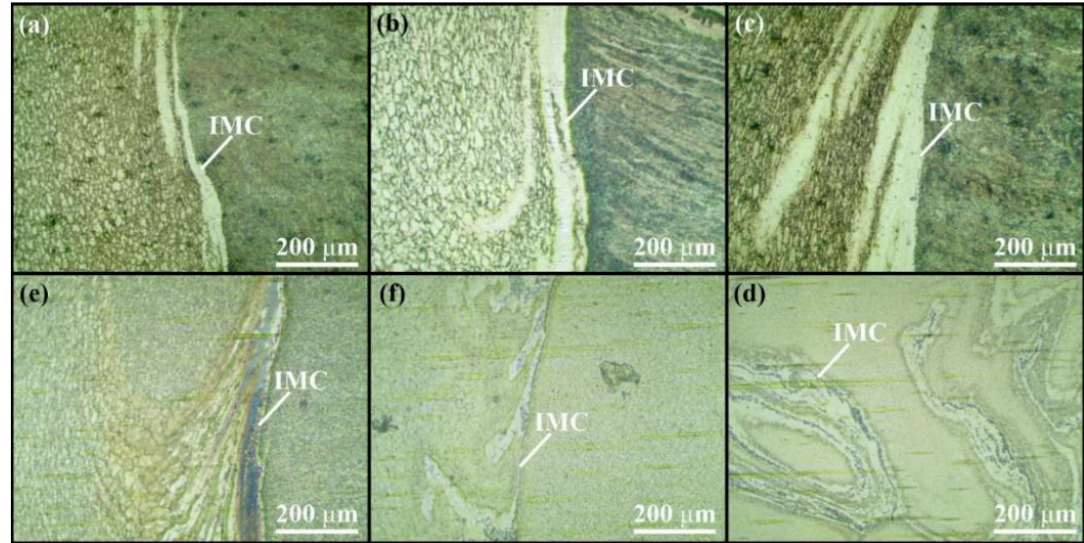
Table 5. Effect of FSW parameters on the strength of the Ti-4Al-3Mo-1V joint . Figure 4. Microstructure of Ti-4Al-3Mo- 1V alloy joint specimen №1 ( a ), №2 ( b ), №3 ( c ), №4 ( d ), and Figure 4. Microstructure of Ti-4Al-3Mo-1V alloy joint specimen № 1 ( a ), № 2 ( b ), № 3 ( c ), № 4 ( d ), and